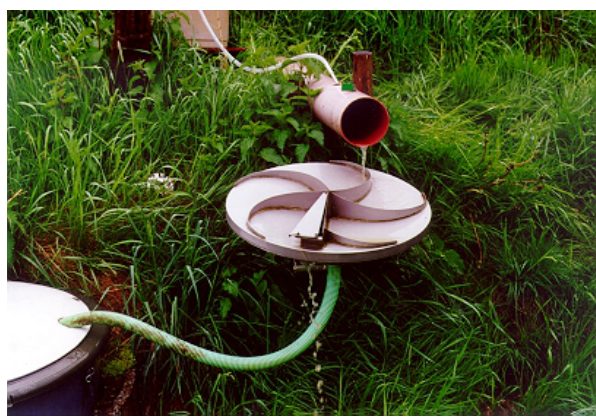
Figure 3. Coshocton-type wheel surface runoff sampling device and collecting tank used to monitor surface runoff and sediment delivery at all watershed